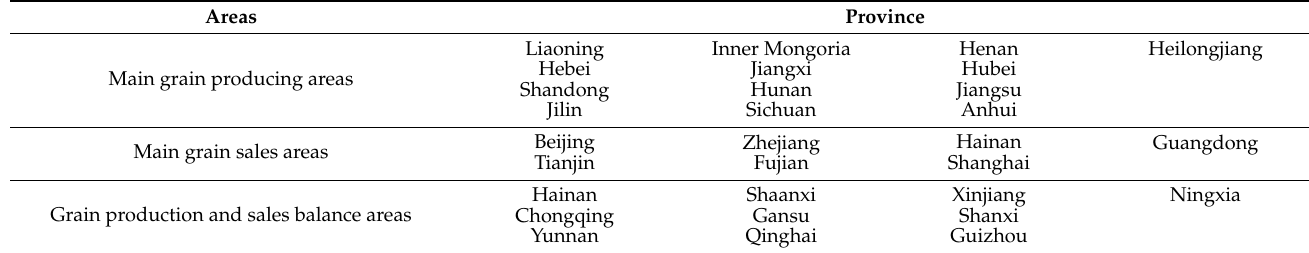
Table A2. Regional division of grain in